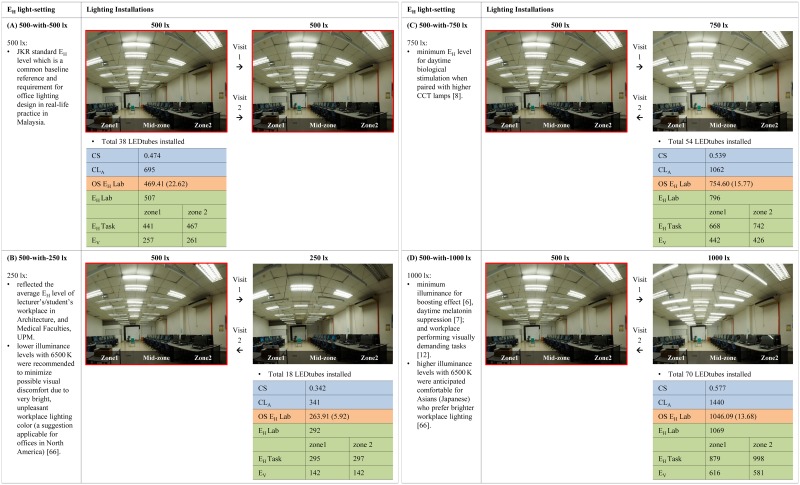
Lighting installation and characteristics of each EH light-setting.(A) 500-with-500 lx. (B) 500-with-250 lx. (C) 500-with-750 lx. (D) 500-with-1000 lx. Public Works Department Malaysia (JKR), Red border indicates similar OS EH Lab levels. Blue shaded values are the Circadian Stimulus Estimation, estimated with CS metric calculator: Circadian Stimulus value (CS), Circadian Light (CLA) circadian lx. Light orange shaded values are the On-Site Measurement performed during each experimental session with the 13 monitors switched on, measured with luxmeter: Mean (SD) horizontal illuminance at 0.755 m from FFL in the mid-zone area (OS EH Lab) lx. Green shaded values are the DIALux Simulated Model Estimation, estimated with DIALux: Average horizontal illuminance at 0.755 m from FFL in the mid-zone area (EH Lab) lx, Average horizontal illuminance at 0.755 m from FFL at Zone1 and Zone2 (EH Task) lx, Average vertical illuminance at 1.105 m from FFL at Zone1 and Zone2 (EV) lx.